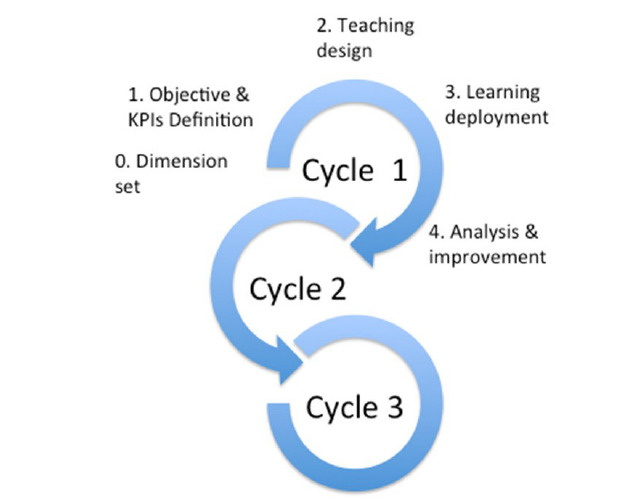
Figure 2. Life cycle of transversal competence at